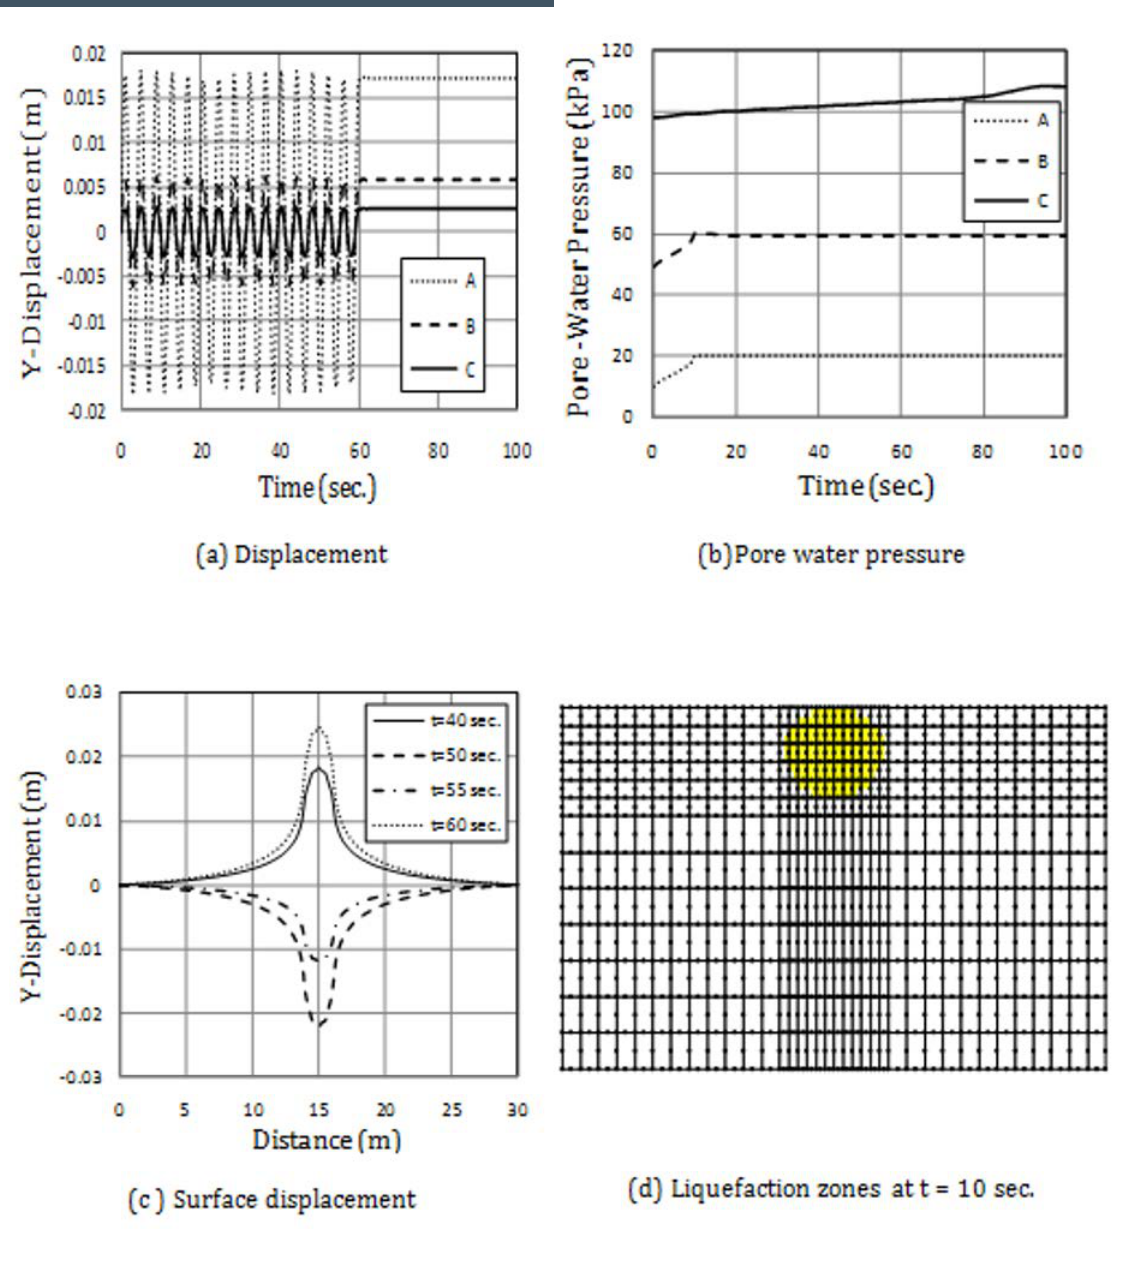
Figure 6. Dynamic response of the foundation to harmonic load, a